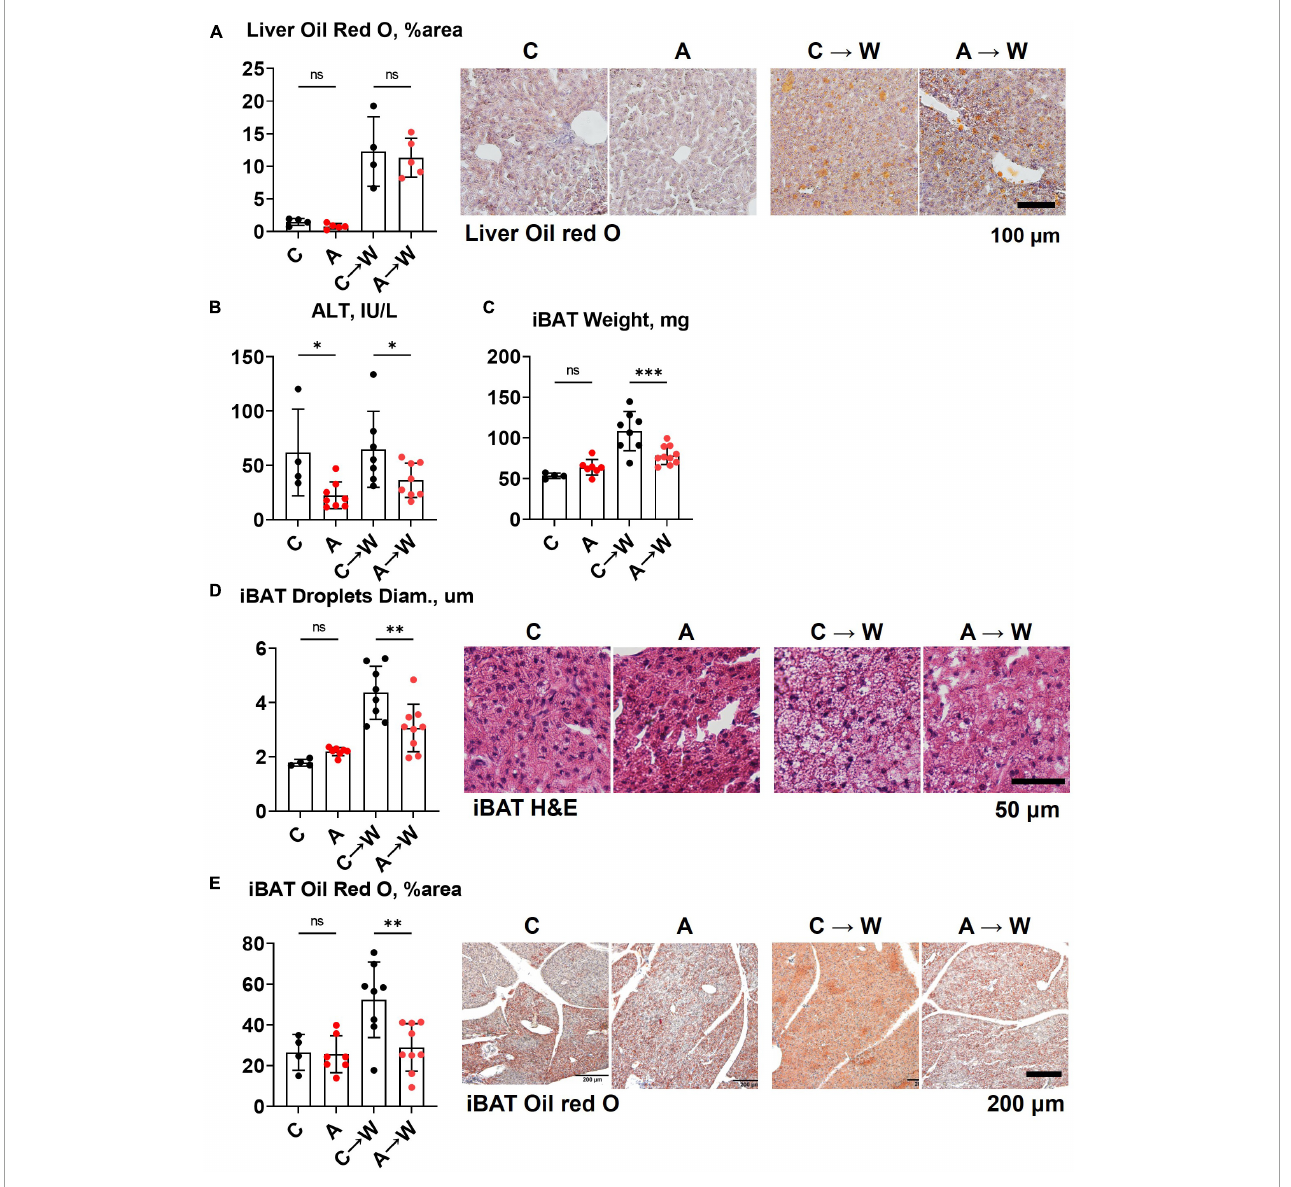
FIGURE7 Liver and brown adipose tissue phenotypes in WHC mice pre-treated with adenine before a western diet. (A) Representative images and quantification of Oil red O staining of the liver. (B) Plasma alanine transaminase (ALT). (C) Interscapular brown adipose tissue (iBAT) weight. (D) Average diameter of lipid droplets in iBAT and representative images of iBAT stained with H&E. (E) iBAT lipis content detected by Oil red O staining. n = 4–9 per group; two-way ANOVA; ns, not significant; ∗ p < 0.05; ∗∗ p < 0.01; ∗∗∗ p <